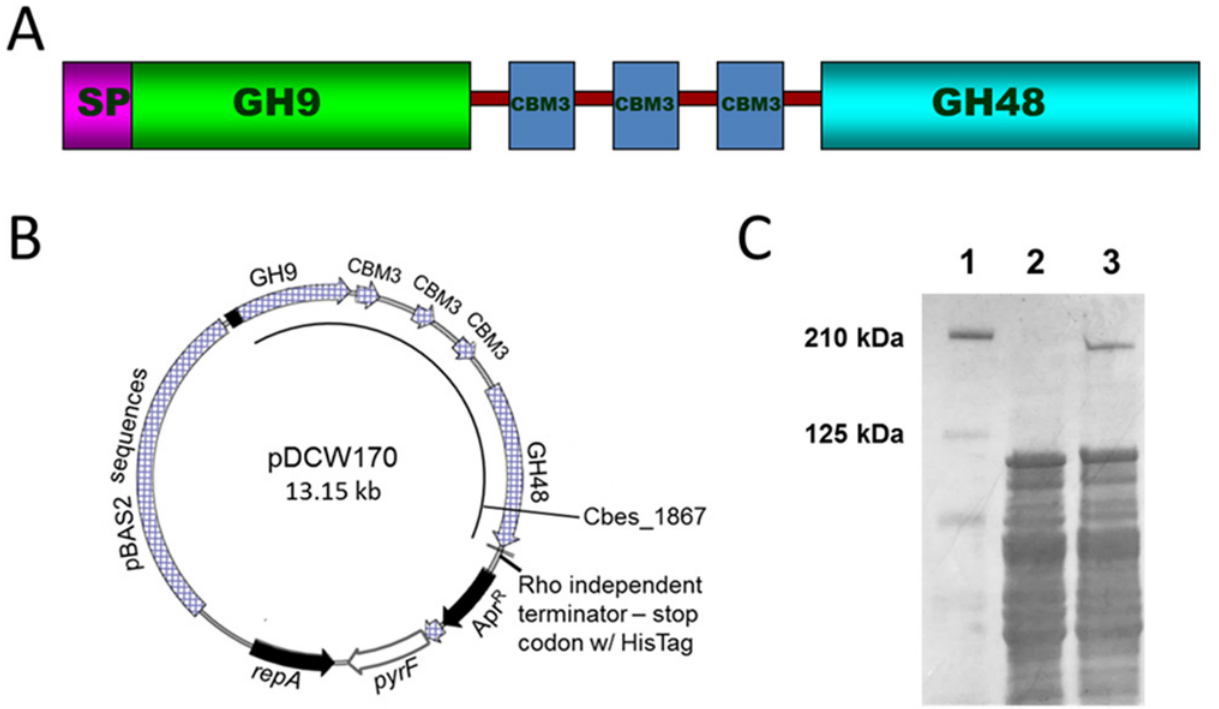
Fig 1. Expression of full-length CelA in C . bescii . A) A diagram of CelA: SP, signal peptide; GH9, Family 9A glycoside hydrolase domain; CBM, carbohydrate binding modules — one family 3 type C followed by two family 3 type B; GH48, Family 48 glycoside hydrolase domain. B). An expression cassette that contains the regulatory region of the C . bescii S-layer protein, a C -terminal 6X His-tag version of celA (Cbes1867), a Rho-independent terminator, the pyrF (from C . thermocellum ) cassette for selection in C . bescii and pBAS2 sequences for replication in Caldicellulosiruptor spp . C) SDS- PAGE gel (4 to 15% gradient) stained with Coomassie Brilliant Blue showing 100 μ g of cell free extract from: Lane 1, MW standards (BioRad); Lane 2, wild type C . bescii JWCB001; Lane 3, JWCB040 Δ pyrFA pDCW170:: celA .